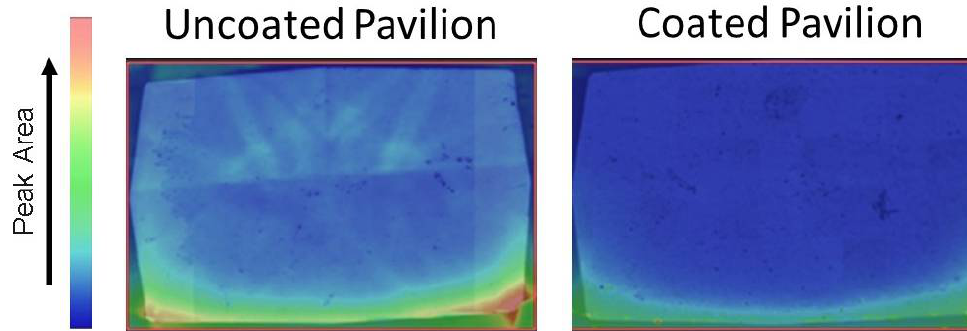
Figure 2. These PL maps were collected on the table of a faceted diamond at liquid nitrogen temperature. The PL map on the left was collected without any graphite coating on the pavilion faceted while the PL map at right had the coating to reduce the pavilion reflections.